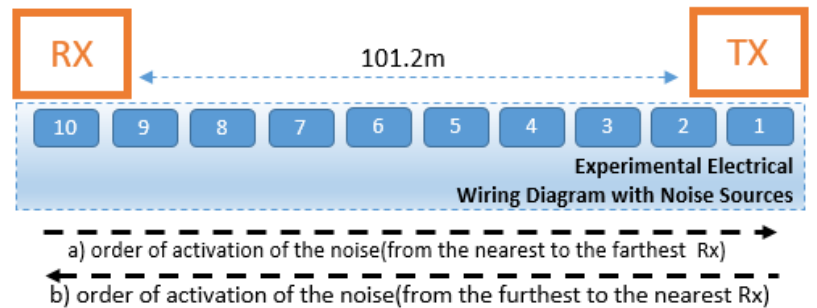
Figure 3. Test Scenario 1: Positioning of noise sources, as a function of the greatest distance from the Tx and the total distance between Tx and Rx